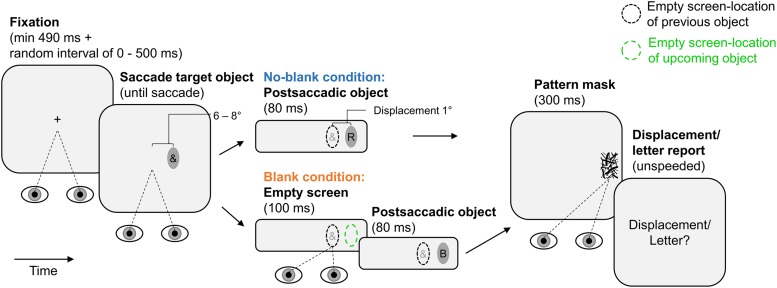
Paradigm of Experiment 1. Observers made a saccade to an elliptic object containing an irrelevant special character. The object was displaced during the saccade. The postsaccadic object contained a letter. It was shown for 80 ms (pattern-masked), either immediately after the saccade (no-blank condition) or after a 100 ms blank (blank condition). Displacement direction was reported in one report block, letter identity in the other. Ellipses of broken lines provide reference positions (they were not shown on the screen): A black ellipse of broken lines indicates the location of a previous object, a green ellipse of broken lines indicates the location of an upcoming object.